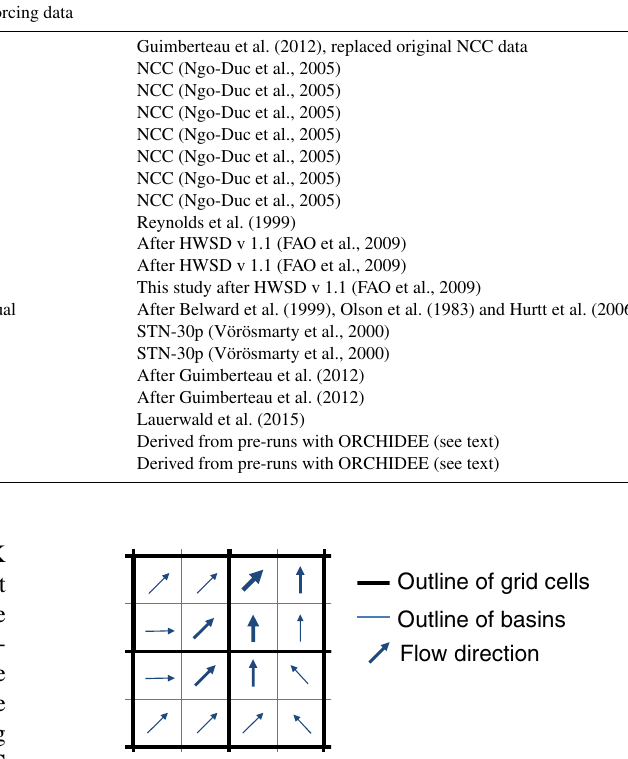
Table 1. List of forcing data needed to run ORCHILEAK. See text for explanations and Fig. 6 for an overview. Variable